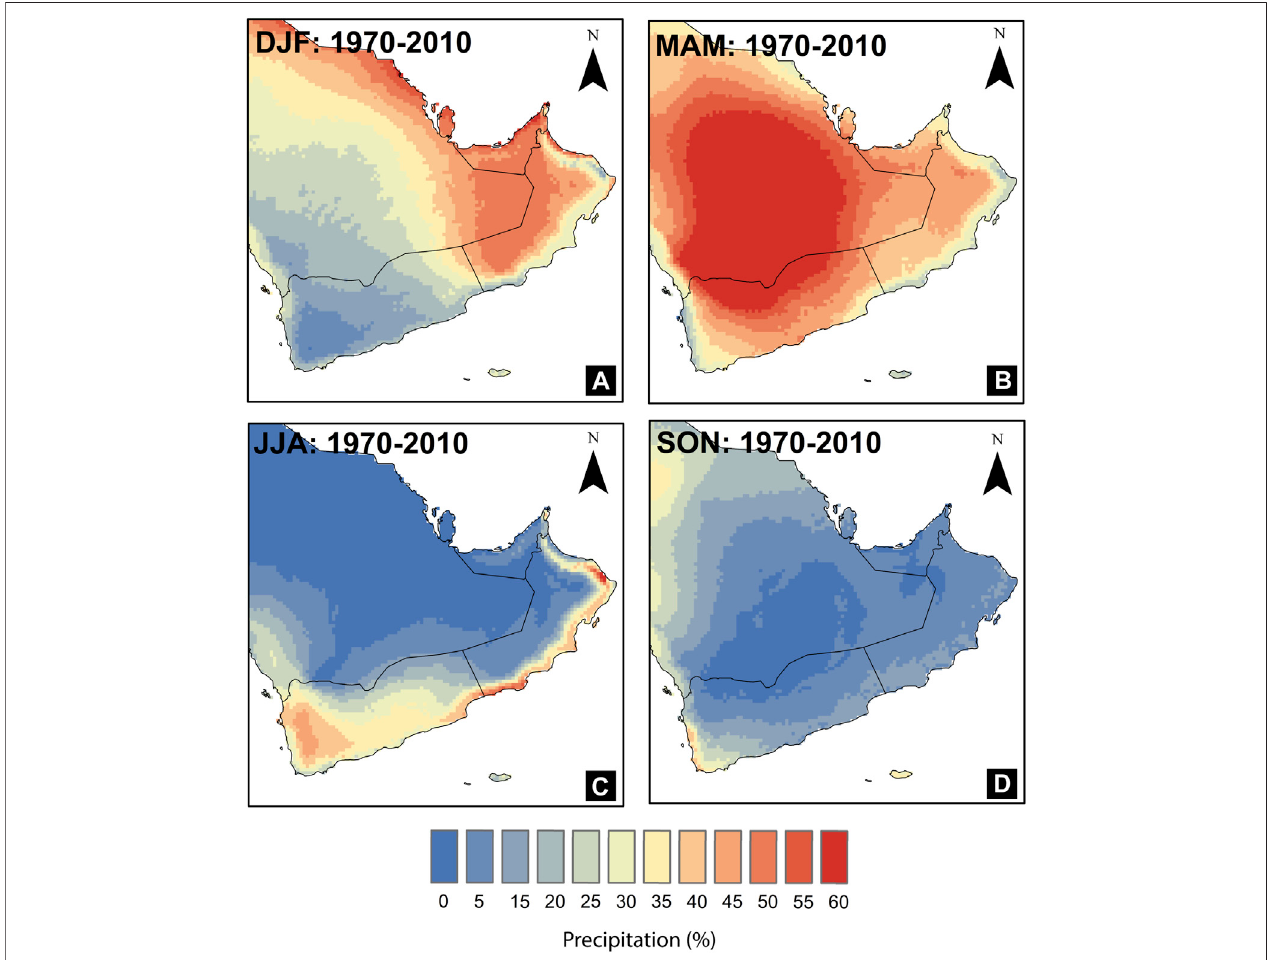
FIGURE 2 | The proportion of rainfall (1970 – 2010) by seasons: (A) winter (Dec-Feb), (B) spring (Mar-May), (C) summer (Jun-Aug), and (D) fall (Sept-Nov) (Source: WorldClim 2021).